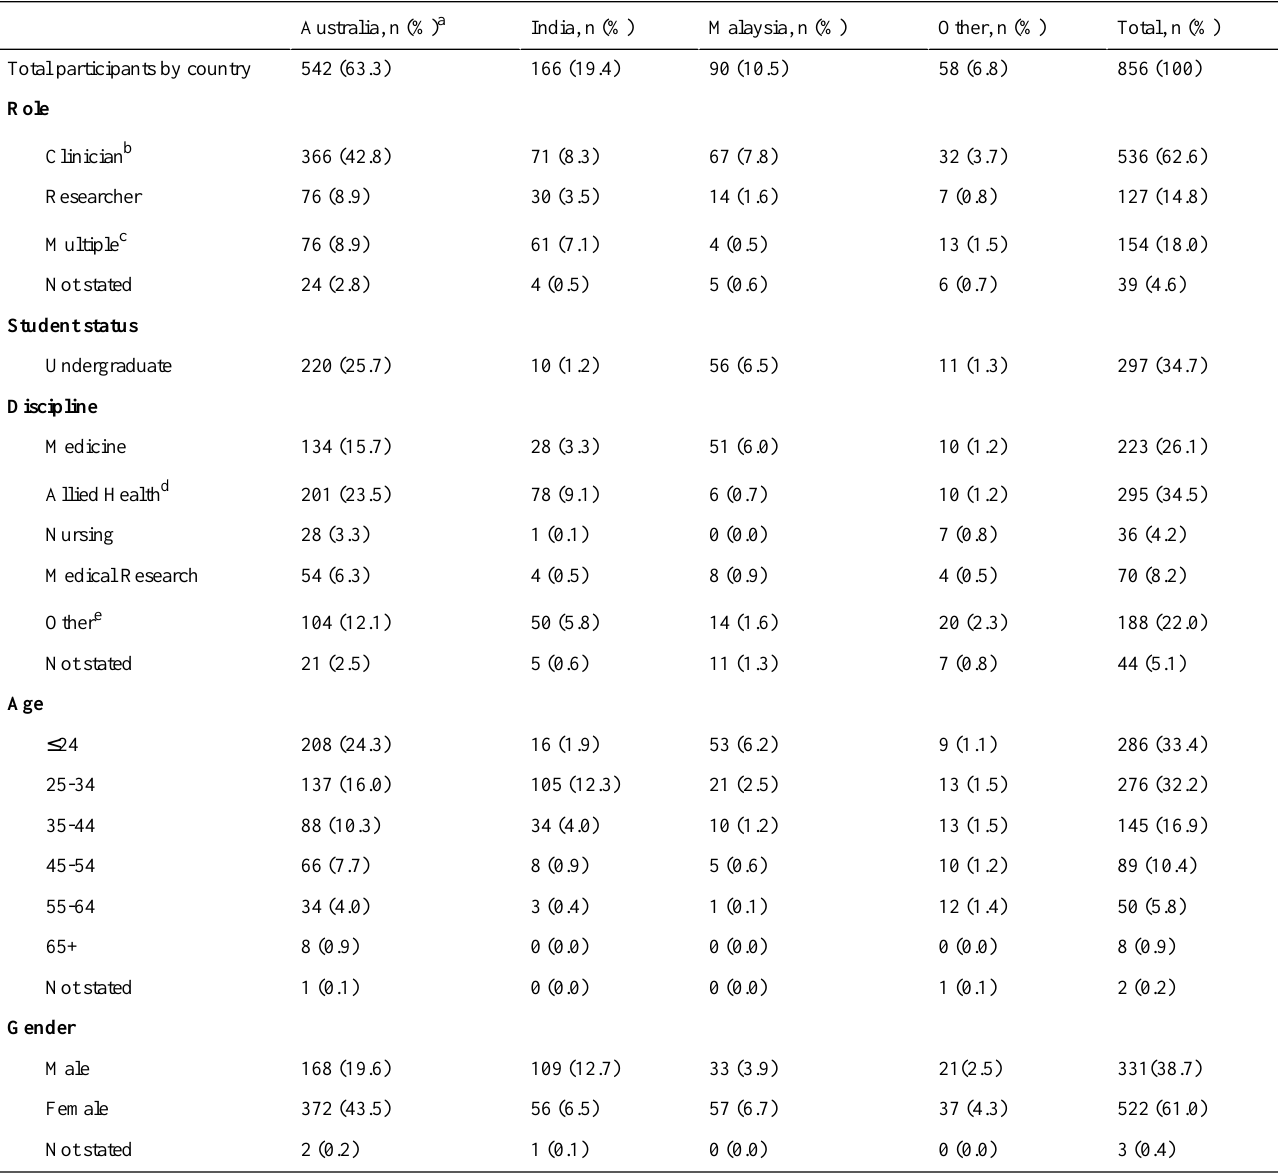
Table 1. Demographic details of